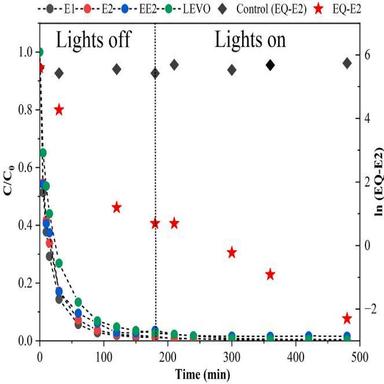
Remaining concentration of each hormone C/C0 in different intervals of time (left y-axis); and Estrogenicity reduction expressed as ln EQ-E2 (right yaxis) during adsorption and photocatalytic degradation of E1, E2, EE2 and LEVO in water containing 100 mg L− 1 of TiO2-AC15%-541. o = 100 μg L− 1 ; o = 90 μg L− 1 ; o = 75 μg L− 1 ; o = 62 μg L− 1 . Control (solution without composite).